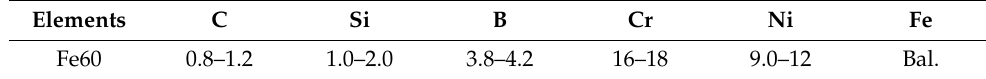
Table 1. Composition of the Fe60 powder.